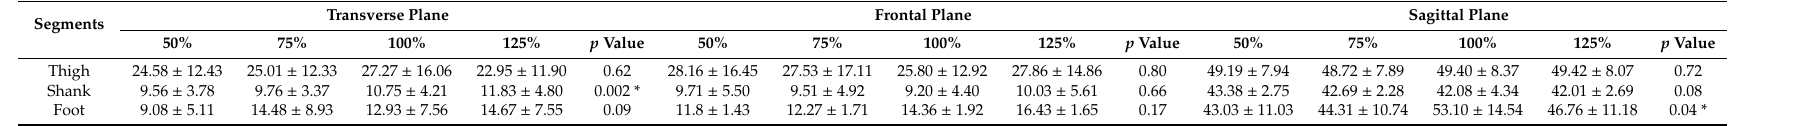
Table 2. Segment ranges of motion (ROM) in transverse, frontal, and sagittal plane during pedaling at di ff erent intensities.